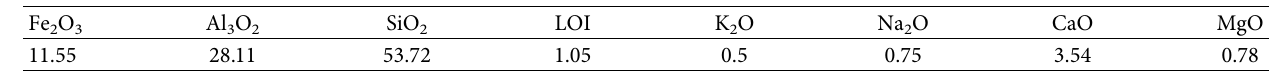
Table 6: Chemical composition of fy ash (%).